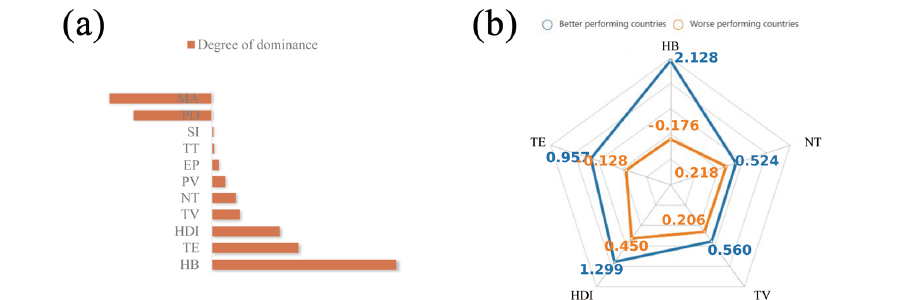
Figure 9. Comparison of the significance of representative indicators for evaluated countries. ( a ) The degree of dominance of the input indicators. ( b ) The mean score of five